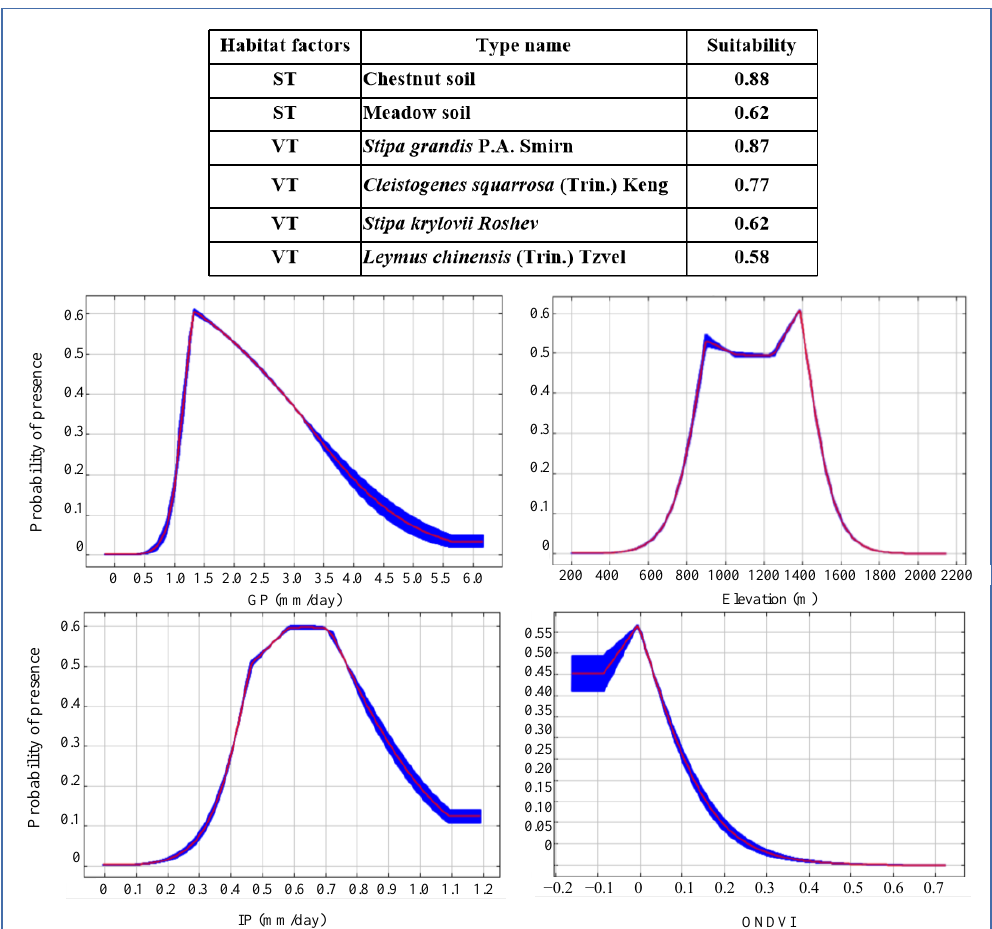
Figure 6. Response curves of dominant habitat factors in the model. Response curves show the re- lationships between existence probability of pest and the six habitat factors. For each panel, the X and Y axes represent habitat factors and probability presence. Red line represents the average of 10 replicates, and the blue margins represent standard deviation of the 10 replicates.